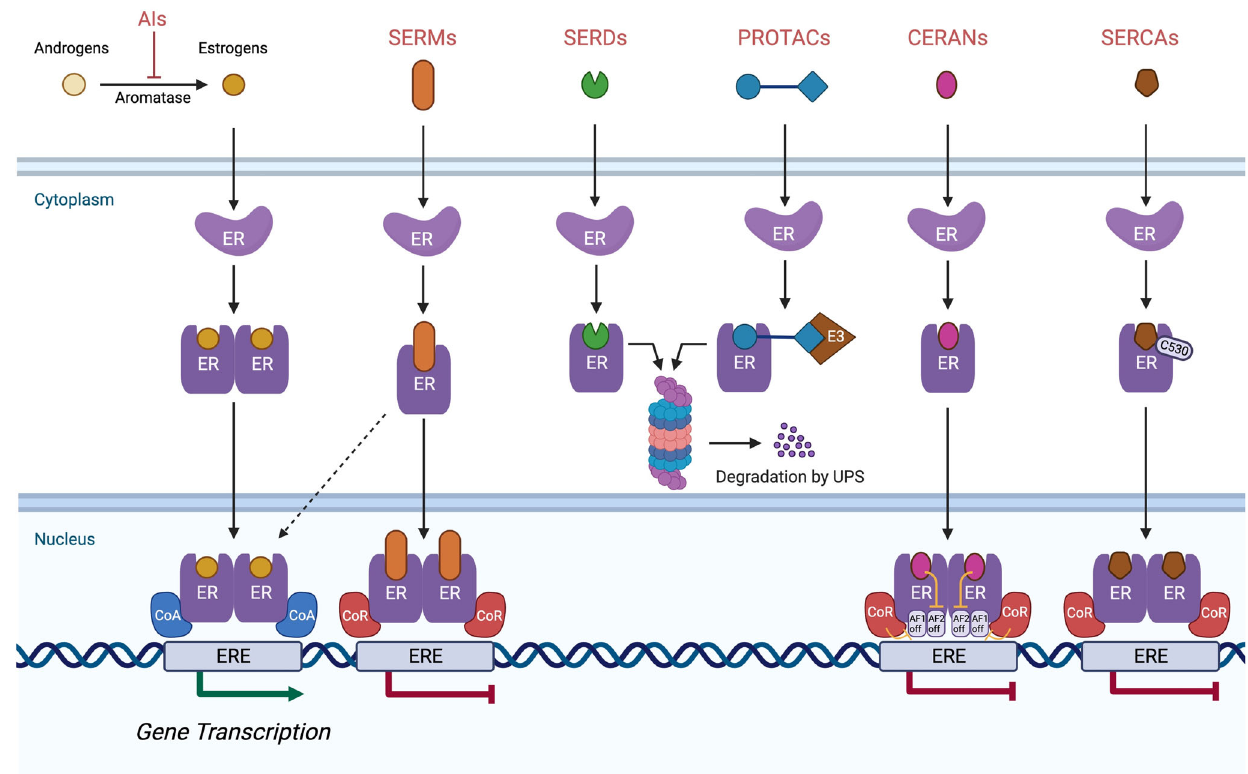
Fig. 1 Mechanisms of action of various classes of anti-estrogen therapies. The binding of estrogen to the ligand-binding domain of ER induces an activating conformational change enabling its dimerization and intranuclear localization. Activated ER can interact with estrogen- responsive elements (EREs), allowing for gene transcription, which leads to cell survival and proliferation. Aromatase inhibitors (AIs) . AIs, block estrogen production by inhibiting aromatase, which converts androgens to estrogens. Selective estrogen receptor modulators (SERMs) . SERMs competitively inhibit the binding of estrogen to ER. SERM-bound ER dimers interact with chromatin at EREs of the DNA. In the breast, they are associated with co-repressors (CoR) which inhibit ER transcriptional activity, but in other organ tissues such as bone and endometrium, they are associated with co-activators (CoA), allowing for gene transcription. Selective estrogen receptor downregulators (SERDs) . SERDs are pure ER antagonists. The SERD – ER complex is unable to translocate to the nucleus or undergo an open chromatin conformation that would allow transcription of ER-regulated genes. The SERD-ER complex subsequently undergoes proteosomal degradation. Proteolysis targeting chimerics (PROTACs) : PROTACs are bifunctional molecules that consist of a ligand that binds to a target protein (ER) and another ligand that binds to the E3 ubiquitin ligase. The interaction results in ubiquitination and degradation of the target protein through the ubiquitin-proteasome complex. Complete estrogen receptor antagonists (CERANs) . CERANs block both transcriptional activation domains (AF1 and AF2) of ER by recruiting nuclear receptor corepressors (N-CoR) to inactivate AF1 and directly inhibit AF2. Selective estrogen receptor covalent antagonists (SERCAs) . SERCAs covalently bind to a cysteine residue (C530) on ER, resulting in ER inactivation and inhibition of gene